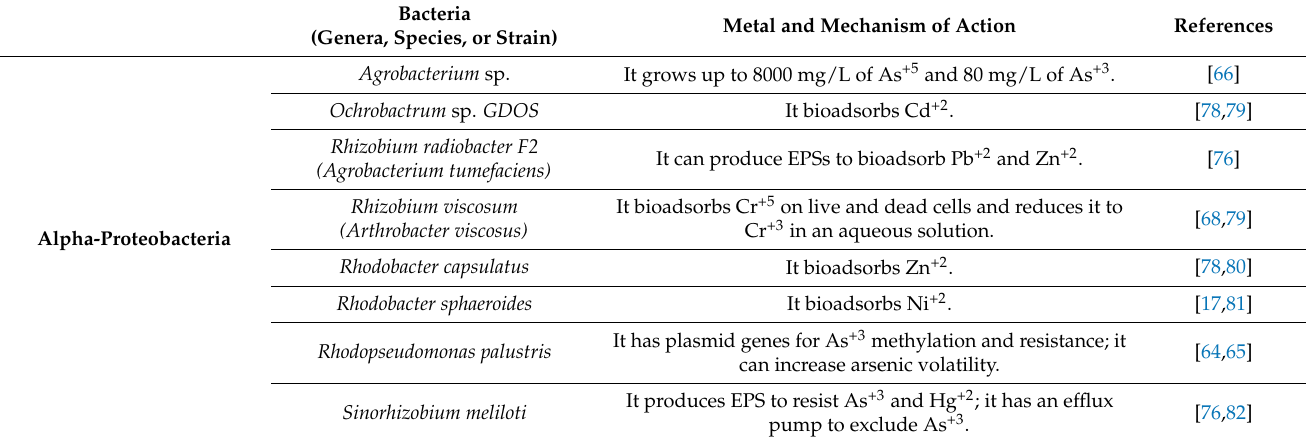
Table 2. Bacterial species able to resist HMs through various mechanisms (detoxification, mobilization, immobilization and metal transformation). EPS: